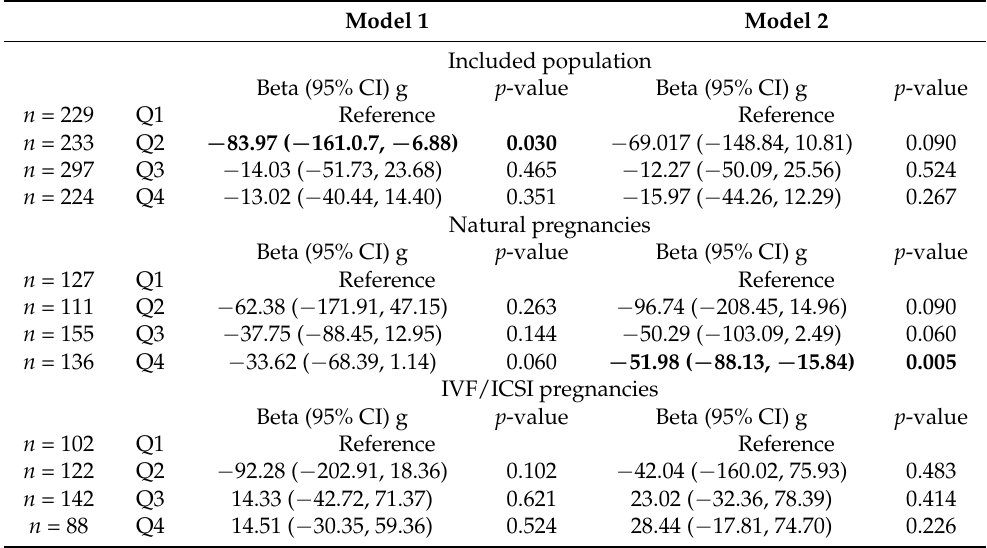
(Table S7). Homocysteine did not influence the odds of having SGA and LGA neonates (Table S6), nor the odds of being born preterm or having a low birth weight. Table 4. Association between quartiles of homocysteine and birth weight in the included population ( n = 983), natural pregnancies ( n = 529), and IVF/ICSI pregnancies ( n =